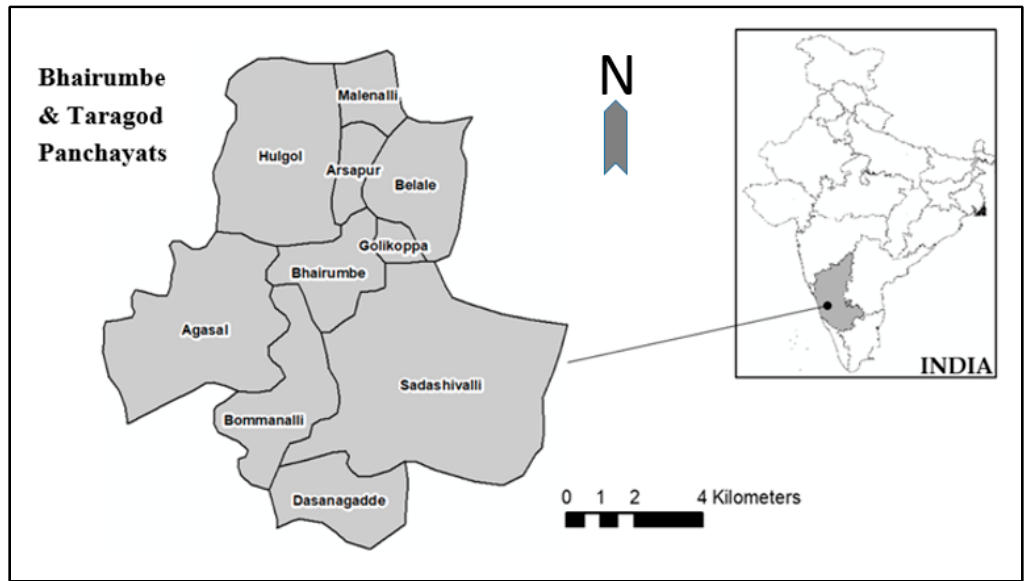
Figure 1. The study area map of the Bhairumbe and Targod Panchayat in Uttara Kannada District, India. (Source: authors).